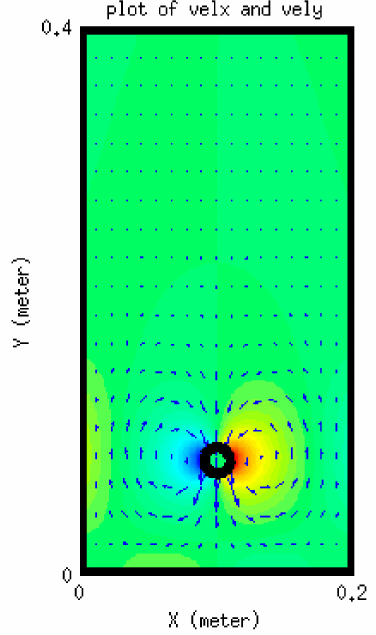
Figure 12. Velocity vectors of the